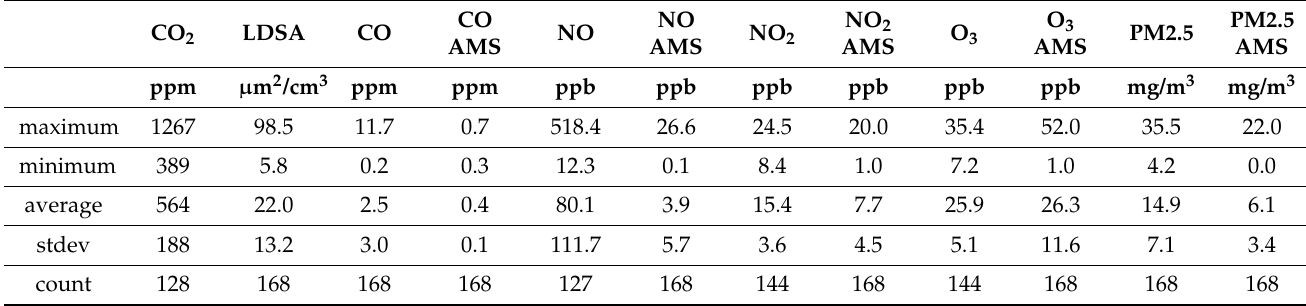
Table 3. Garage and MPCA air monitoring station (AMS) 1 h average